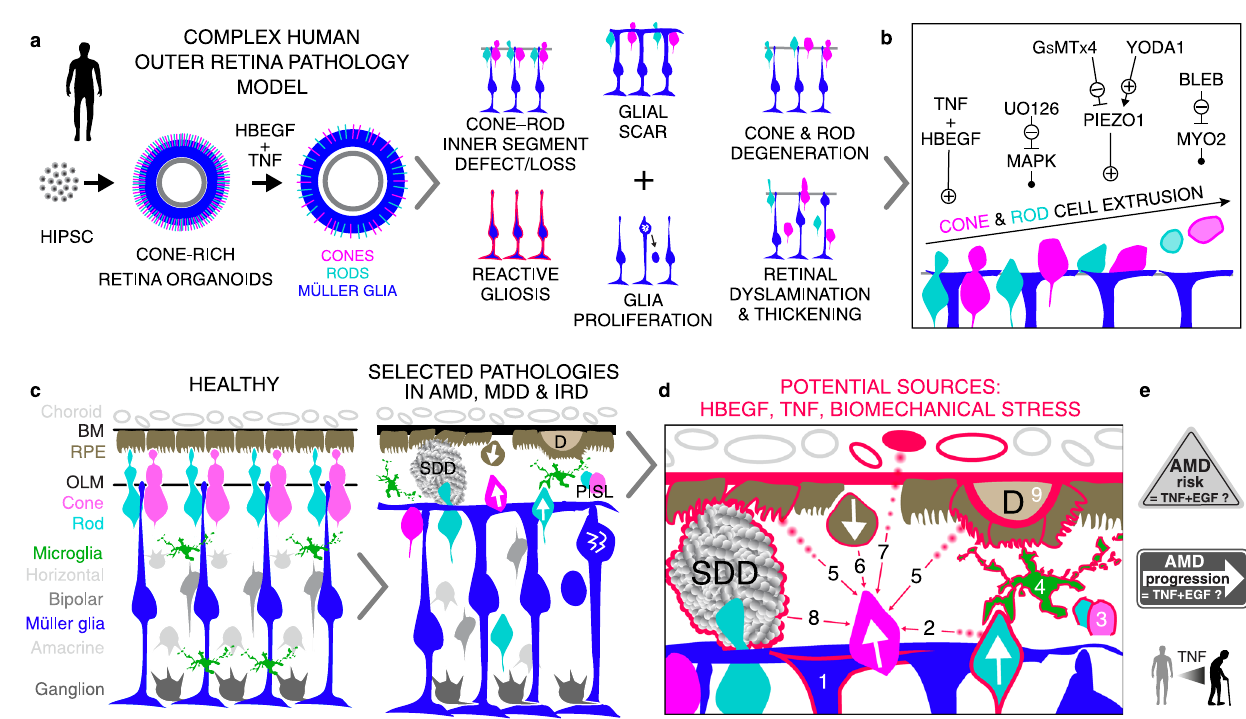
Fig. 10 | Summary: HT-HRO model phenotype, mechanism, and potential relation to retinal pathologies. a Scheme of the HBEGF-TNF (HT)-induced pathology model in human retinal organoids (HT-HRO): several distinct histo- pathologic processes progressively develop in a spatiotemporally-combined and quanti fi ablemanner.Coneandrodphotoreceptor(PR)degenerationviaapicalcell displacement(ectopy)outoftheretinawithsubsequentcelldeath,combinedwith several Müller glia (MG) pathologies, is one complex phenotype. (Ultra)structural, molecular,andfunctionalpharmacologicalinhibitordataindicateamechanism:( b ) HTapplicationorPIEZO1activationinducesPRdegenerationviacellextrusionwith or without extensive glial pathologies, respectively. Inhibition of MAPK (UO126), PIEZO1 (GsMTx4), or actin-myosin (BLEB, Blebbistatin) signaling each effectively prevents not only PR extrusion but also the complex phenotype. c Summary scheme depicting healthy human retina and selected pathologic processes potentiallyrelevant for AMD and other pathologies, and d , e potentialsources and functions of TNF, HBEGF(EGFmay havea similar effect),and biomechanicalstress in retinal pathologies (indicated in red and numbered) as a basis to discuss